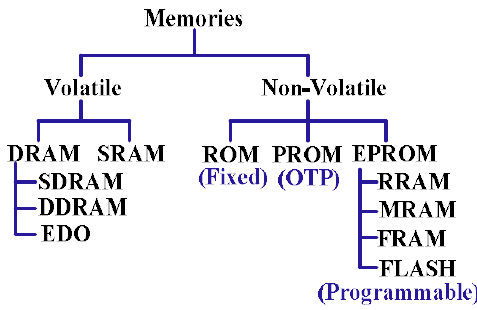
Figure 1. Computer memory classifications based on data retention.